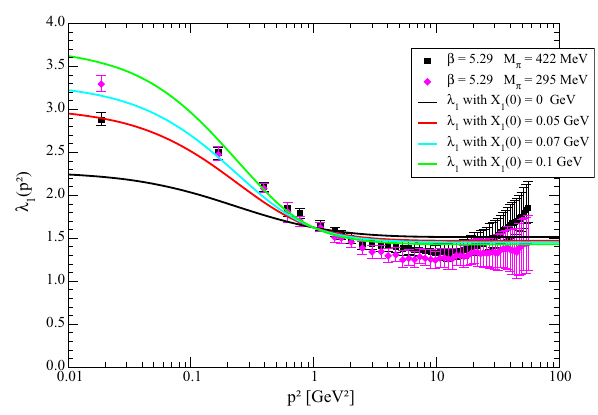
Fig. 43 The soft gluon limit prediction for λ 1 . See text for details where p is the quark incoming momenta, and in our